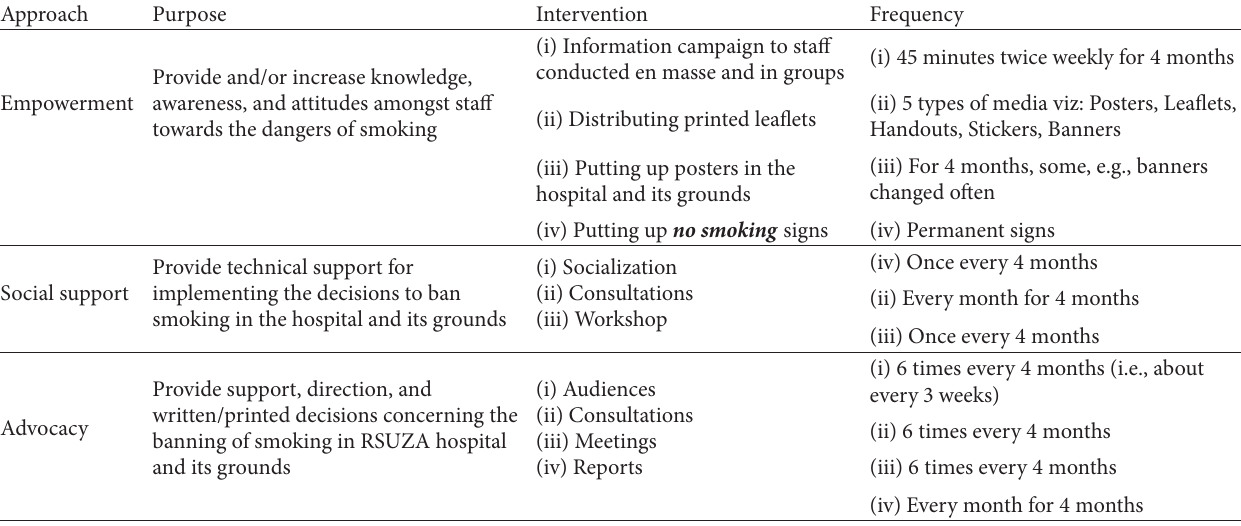
Table 5: Health promotion interventions strategies to change behavior of smoking staff.